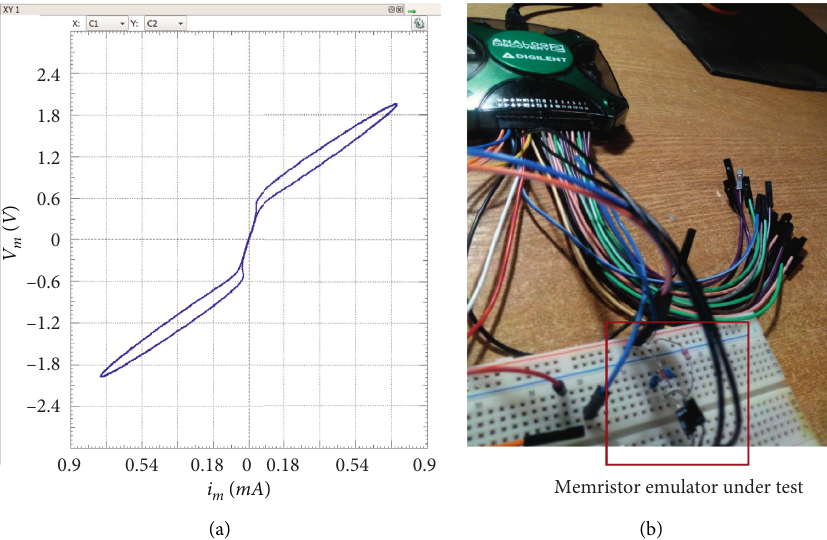
Figure 4: (a) V - i characteristics obtained through the measurements of an implemented memristor emulator driven by a current source � I ( 2 π ft ) at a constant frequency f � 1500Hz with I i m o sin